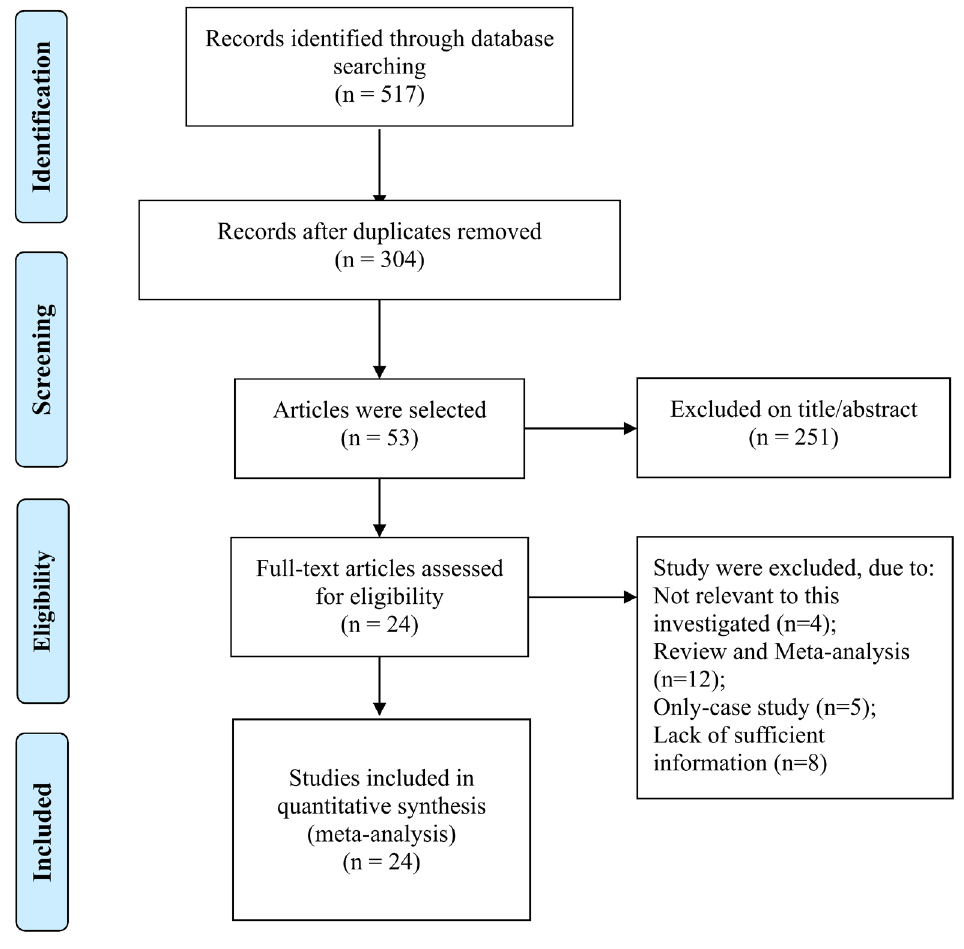
Figure 1: Flow diagram of the publication selection process.